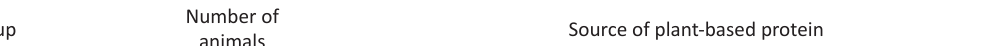
Table 1. Feeding trial design Number of Group animals Grower diet 1 – 50% of protein from GM-SBM was replaced with protein from the analyzed high-protein feed